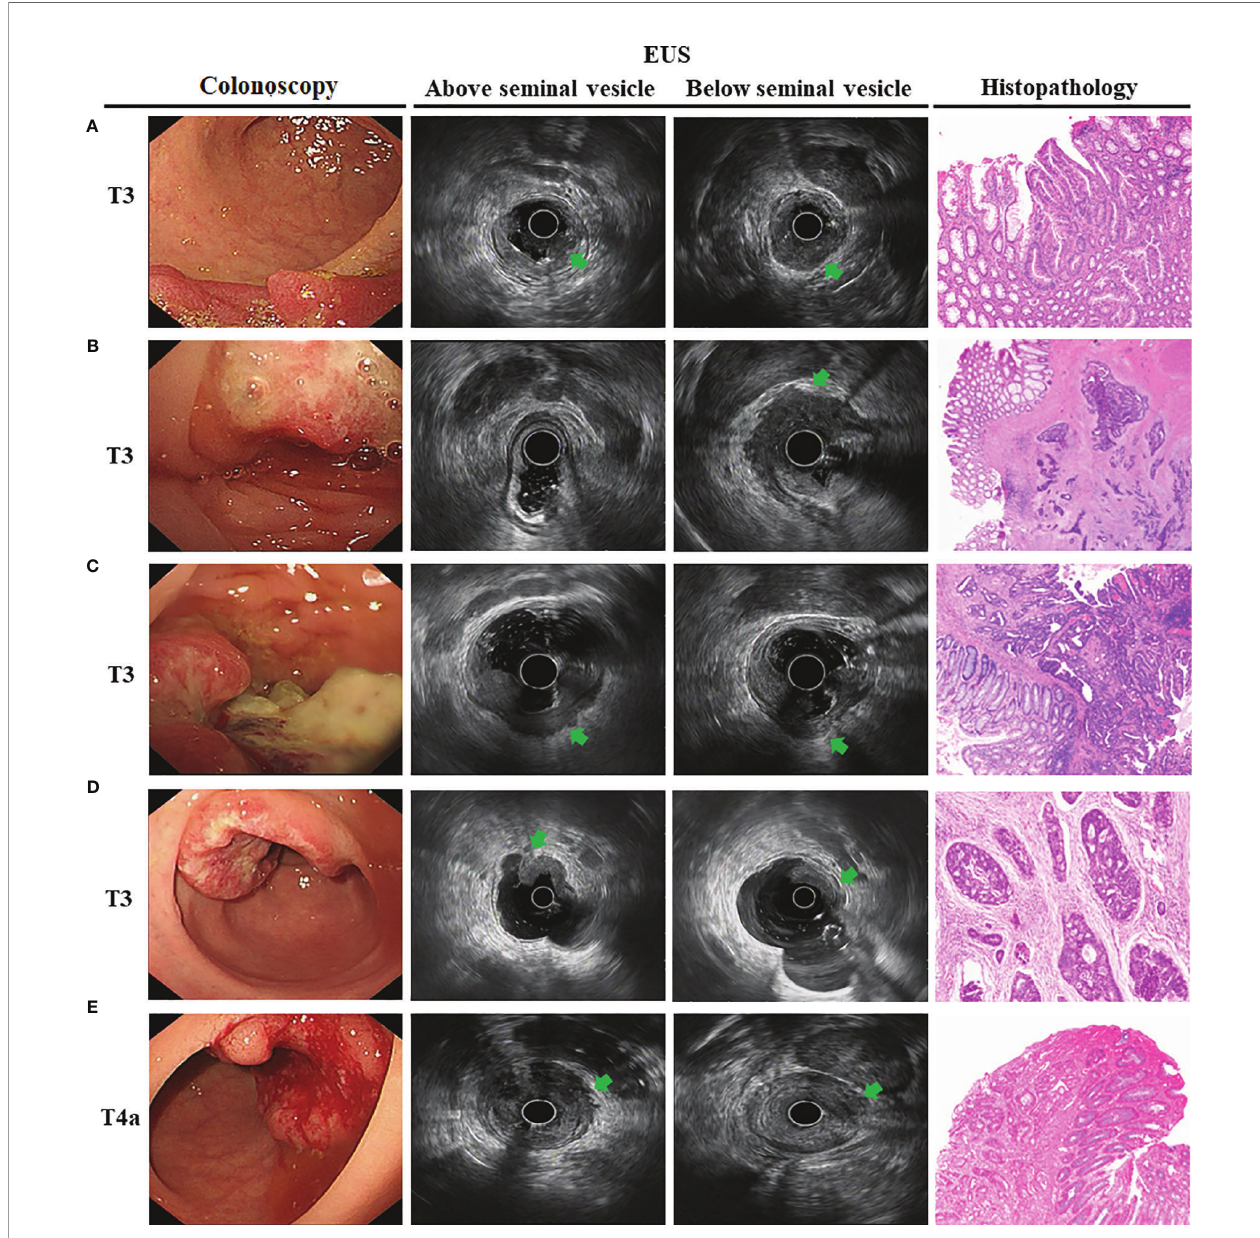
FIGURE 3 | The endoscopic ultrasonography image features in T3 and T4a tumor T stage for male. Endoscopic images of the lesions showed neoplasms located at the rectum with dirty surface. (A) EUS images showed a thick hypoechoic lesion spreading from the mucosa to the whole rectal wall. The lesion located at posterior rectum and below the seminal vesicles ( arrowheads ); (B) The lesion located at anterior rectum and below the seminal vesicles ( arrowheads ); (C) The lesion located at posterior rectum but above the seminal vesicles ( arrowheads ). This T3 tumor penetrates the rectal wall and invaded perirectal fat; (D) The lesion located at anterior rectum and above the seminal vesicles. However, hypoechoic lesion invaded to entire wall with an intact serosa layer ( arrowheads ), meaning that the tumor is still limited to the rectal wall. The surgical specimen con fi rmed tumor con fi ned to the subserosa; (E) The lesion located at anterior rectum and above the seminal vesicles. However, hypoechoic lesion invaded to entire wall with irregular rectal wall outer edge ( arrowheads ), meaning that the lesion invaded the rectal serosa. The surgical specimen con fi rmed tumor in fi ltrated to the